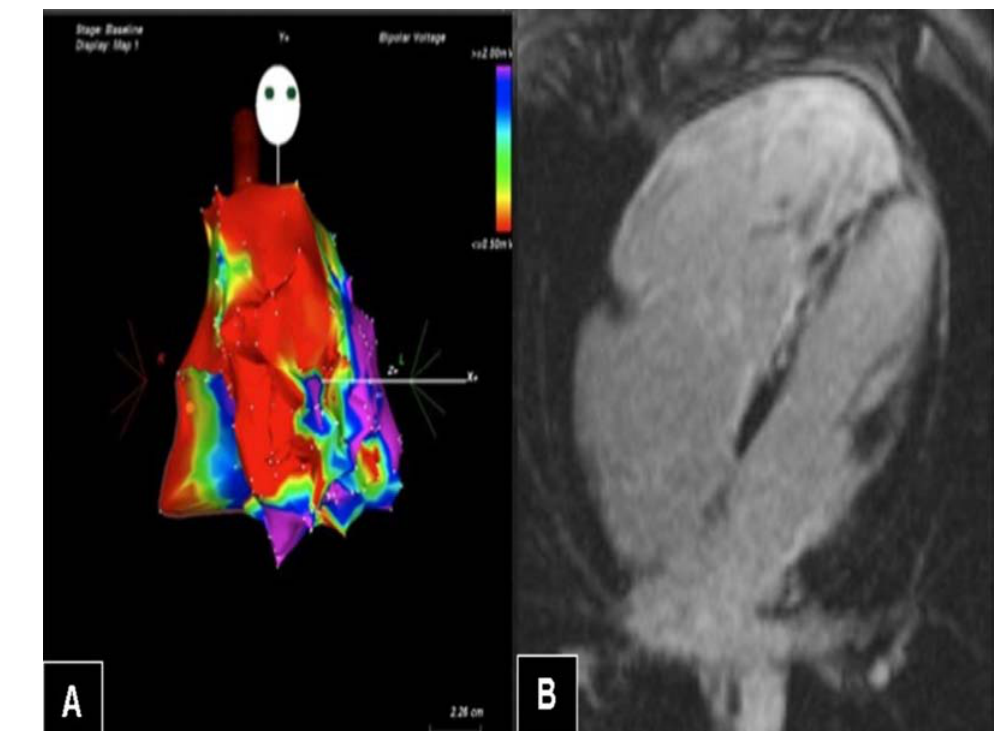
Figure 9. A: Bipolar endomyocardial electrovoltage mapping of a patient with arrhythmogenic cardiomyopathy. Red color represents areas of a low voltage recordings , 0.5 mV indicating a dense scar tissue. B: Cardiac magnetic resonance of the same patient. Extensive fibrotic changes demonstrated by delayed gadolinium enhancement in most of the right ventricular free wall and extending into the interventricular septum (concordant to the electrovoltage mapping findings). (Images courtesy of MP Marra, MD, University of Padua,